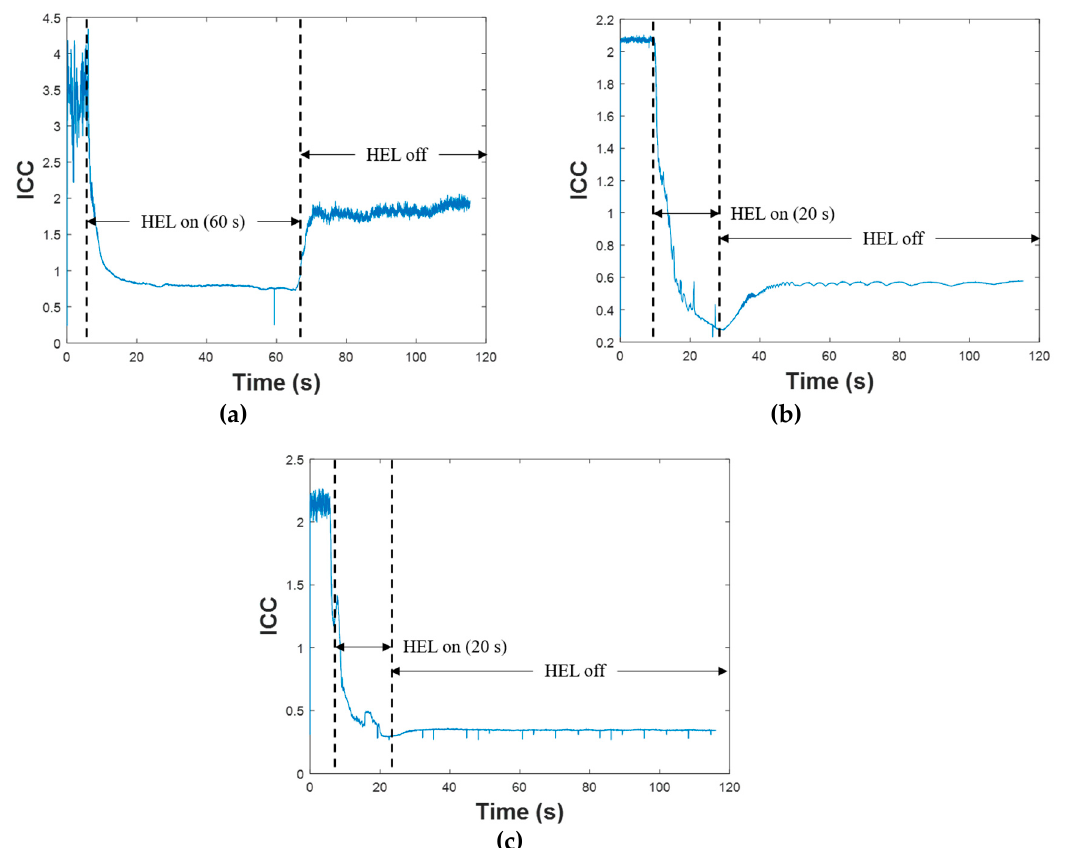
Figure 6. ICC data calculated using Equation (2) based on raw reflectivity data: (a) FBG slightly degraded, (b) FBG moderately degraded, and (c) FBG severely degraded.